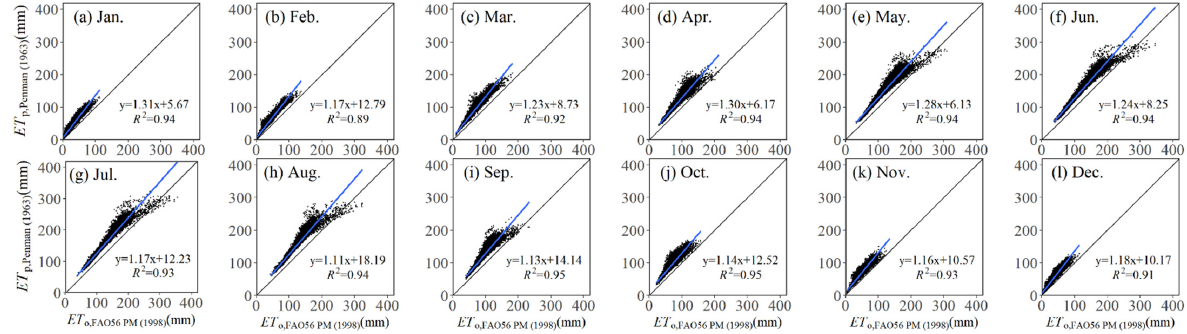
Figure 4. The scatter plots of monthly ET o and ET p for the 12 months (containing 551 sites). The variations in long-term mean monthly ET p , ET o, and their differences D (= ET p − ET 0 ) were also compared for the different sub-regions (Figure 5). The monthly ET p , ET o, and D showed peaks from around May to July. The peak values of ET p and ET o ranged from 144 to 218 mm and 116 to 176 mm for the sub-regions I to VII and for Mainland China, respectively. The peaks in the sub-regions ranked in the order of I > II > V > Mainland China > IV > VII > VI > III. The interannual variations in ET p and ET o were larger for the arid and semi-arid sub-regions (I and II) than the semi-humid and humid sub-regions (III, VI and VII). The monthly ET p were generally larger than the monthly ET o for the same month and the same region. The D values varied within the months of the year, reaching as high as 42 mm in July for the arid and semi-arid sub-region